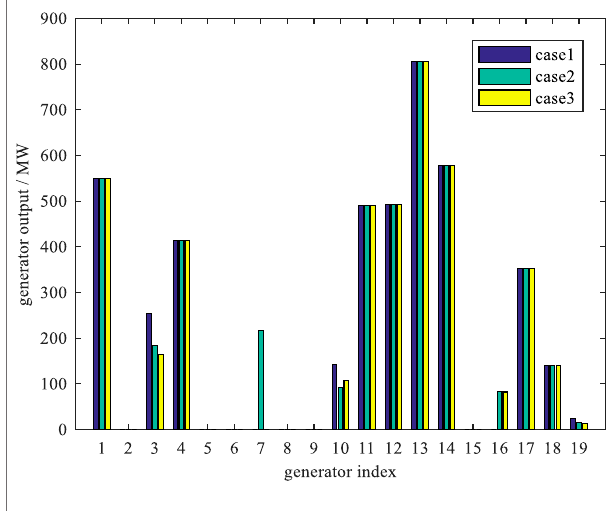
FIGURE 6 | Comparison of generator